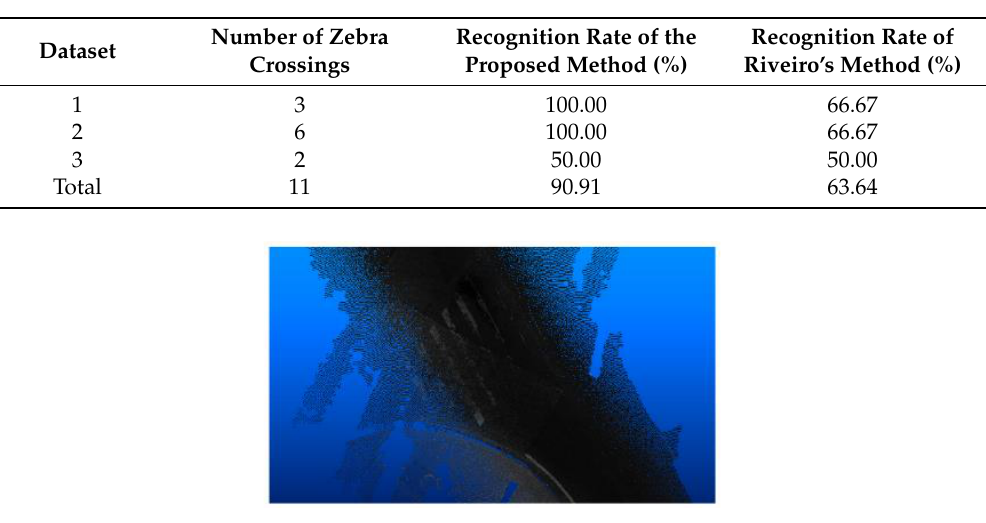
Figure 15. The extracted road markings.